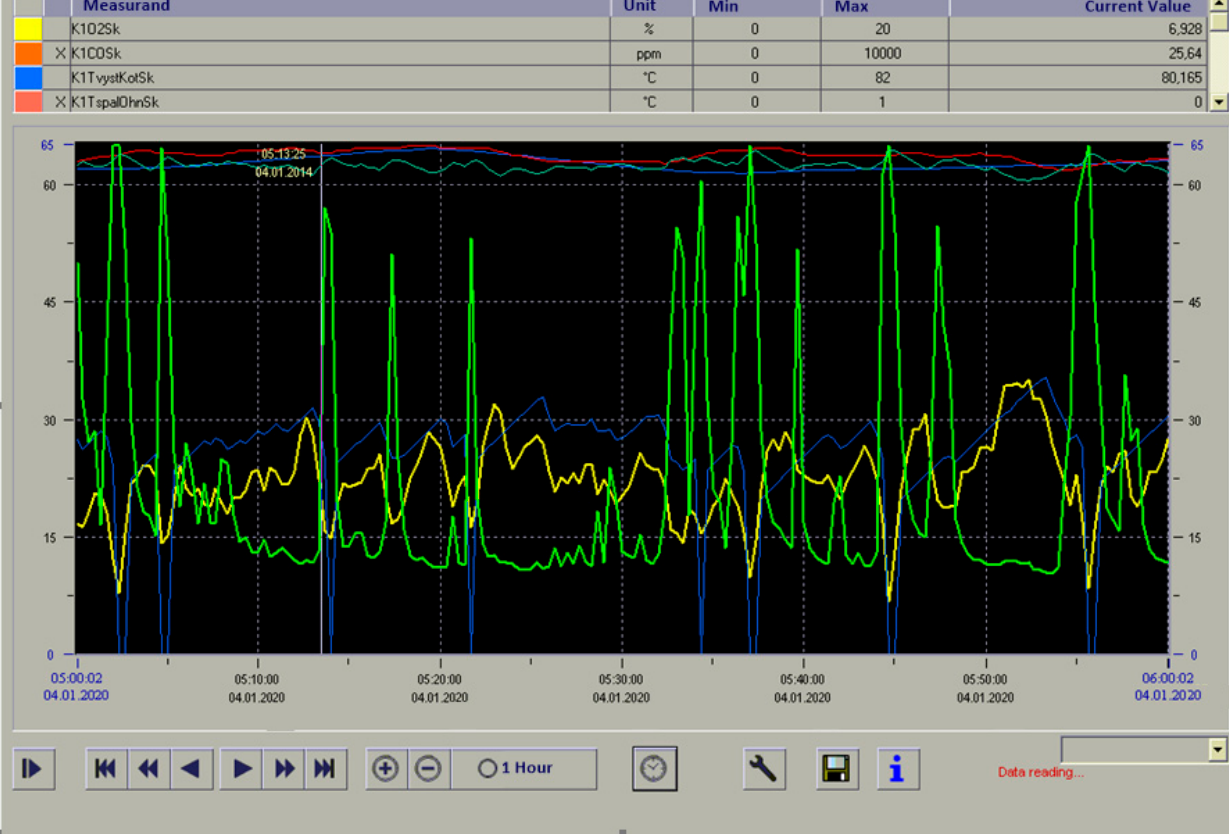
Figure 7. An example of time courses of some monitored process variables. Identification of variables: blue line—the boiler output water temperature, red line—the flue gas temperature, turquoise line—the primary air fan, yellow line—the O 2 concentration, green line—the CO emissions, dark blue line—the fuel supply.